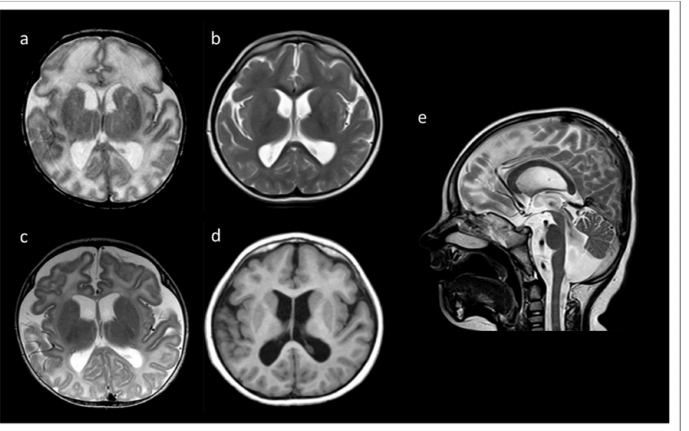
Figure 1. MRI records of the TARP-affected patient. ( a ) At term equivalent age the cerebrum was swollen with increased T2 signal of the supratentorial white matter and a simplified gyral pattern, especially frontal. In the further course, microcephaly with simplified gyral pattern and myelination delay were visible. ( b ) T2 at the age of 3 months. ( c ) T2 at the age of 3.5 years. ( d ) T1 at the age of 3.5 years. ( e ) T2 at 3.5 years of age showing concomitant ventriculomegaly, thickening of the corpus callosum, and pontine and vermis